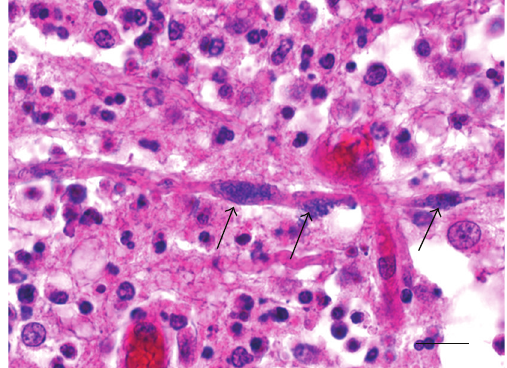
Figure 6: Rhombencephalitis in a sheep: intraaxonal Listeria monocytogenes (arrows) within a microabscess of the medulla oblongata. H&E, bar = 13 μ